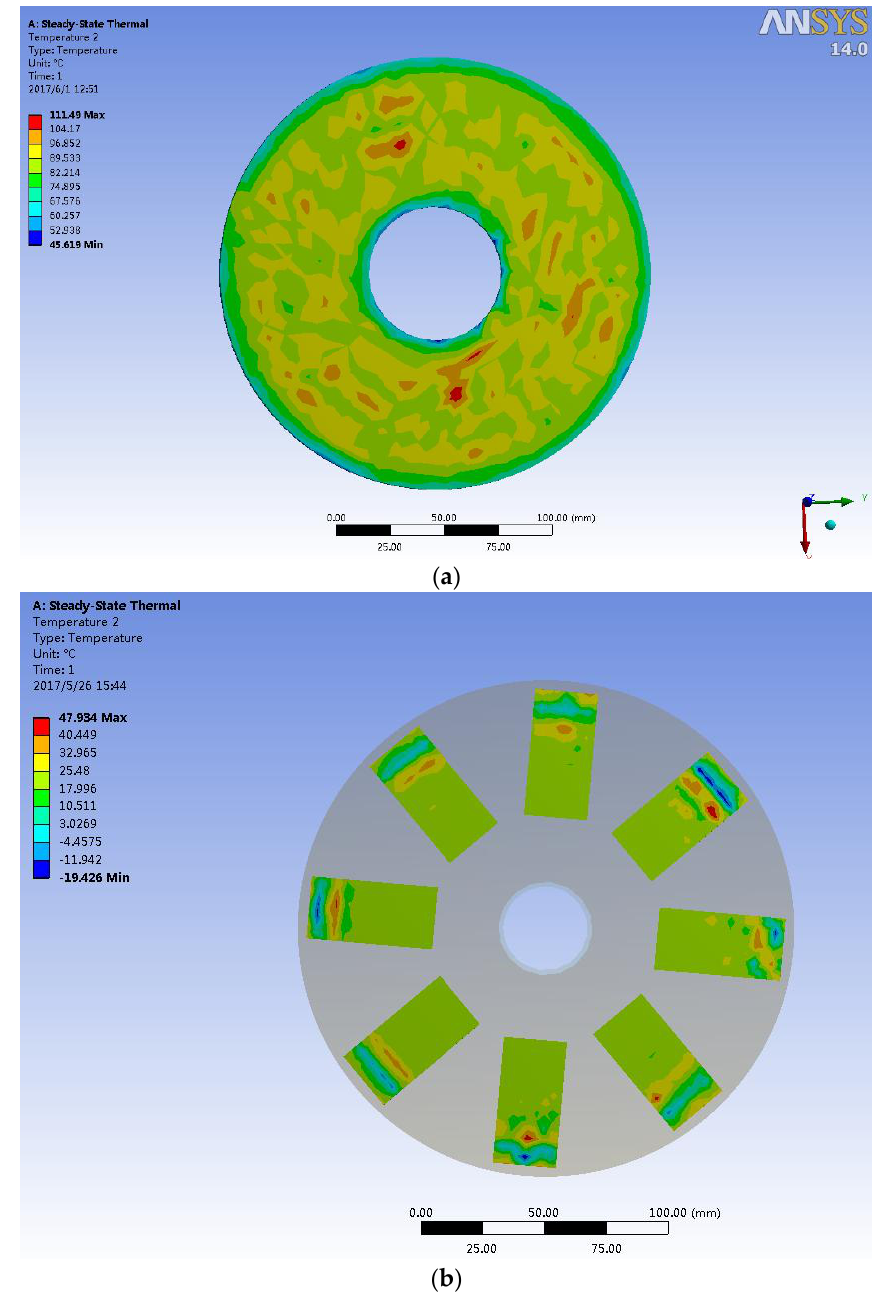
Figure 7. Axial temperature simulation results: ( a ) The axial temperature distribution of the copper plate; ( b ) Permanent magnet temperature distribution.